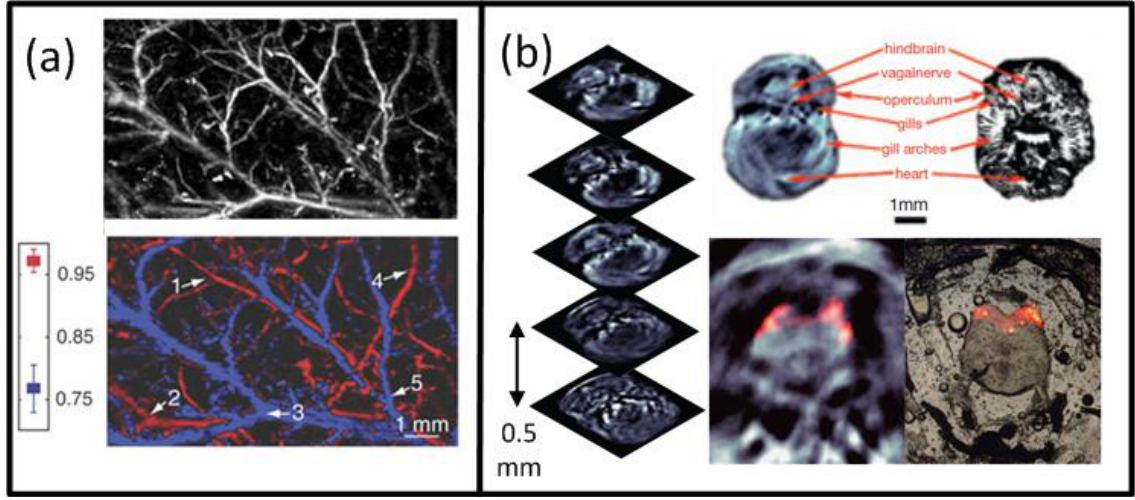
Figure 12. ( a ) Functional OA microscopy by Zhang et al. [44]. Structural in vivo image of rat vasculature taken at 584 nm (top). Functional vessel-by-vessel mapping based on a linear fitting of four different wavelengths (bottom). Reprinted with permission from Nature Publishing Group ; ( b ) In vivo detection of fluorescent proteins by Razansky et al. [45]. OA images of the hindbrain area of a mCherry expressing zebra fish for five different slices taken at 585 nm (left). Selected slice and its corresponding histological section (top right). MSOT image of the brain with mCherry expression shown in color and its corresponding epi-fluorescent histology (bottom right). Reprinted with permission from Nature Publishing